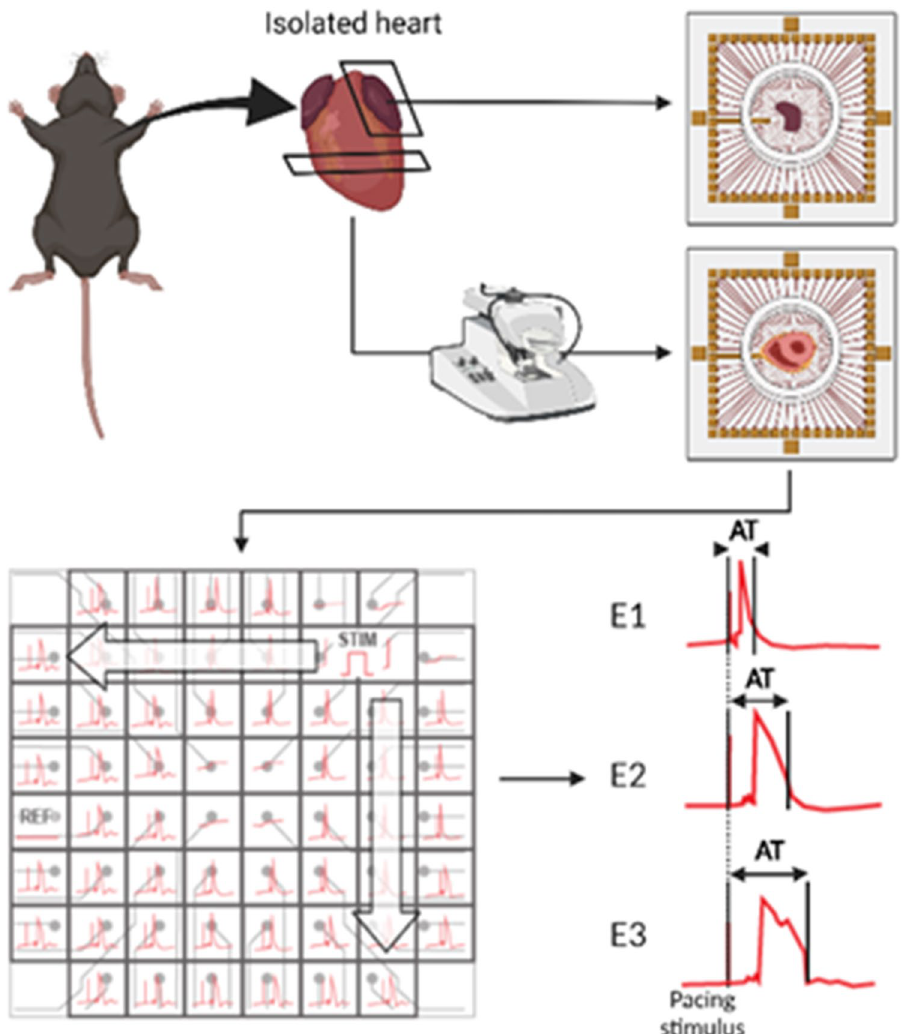
Figure 6. Schematic of murine atrial and ventricular isolation for MEA studies. Murine atrial tissue were placed epicardial surface down whereas transverse cross-section of the ventricle was emplaced onto the MEA for electrophysiological studies. Tissues were weighed down by a weighing harp. Representative electrograms recorded from a ventricular tissue slice using the MEA, with the proximal electrode (E1) and progressively distal electrodes (E2 and E3) to the paced stimulus. STIM indicates site of pacing stimulus, REF indicates the reference electrode position of the MEA. AT indicates activation time measured from stimulus onset to the steepest negative deflection of the electrogram. Created with